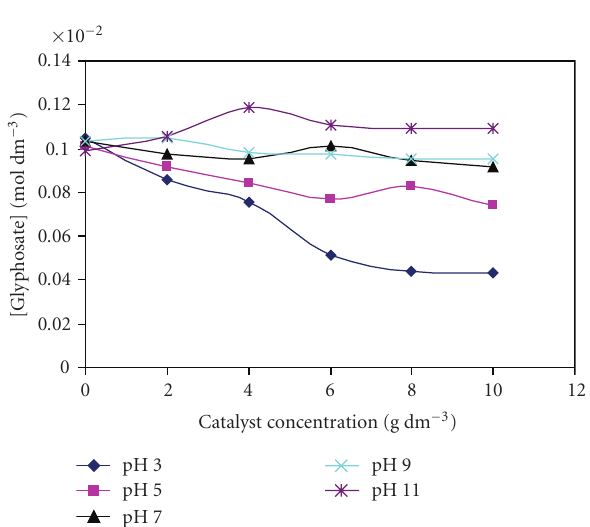
Figure 1: Glyphosate adsorption on the surface of Degussa P25 TiO 2 photocatalyst in the dark at di ff erent pH, assessed by measuring the concentration of free solution glyphosate as a function of solution loading of the